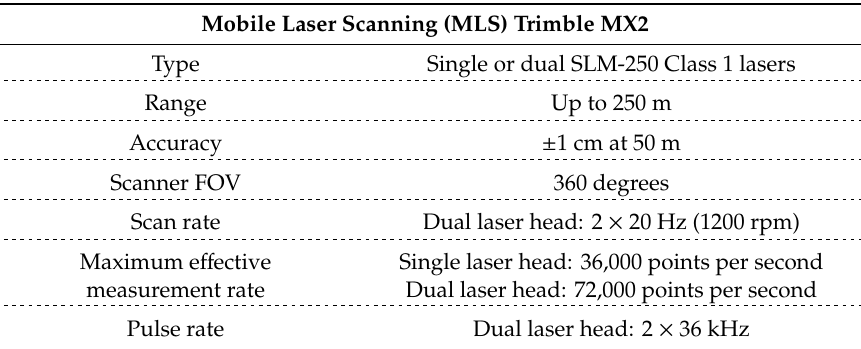
Figure 3. The vehicle equipped with Mobile Laser Scanner (MLS, Trimble MX2 model). Table 2. Specifications of Trimble MX2 [27].